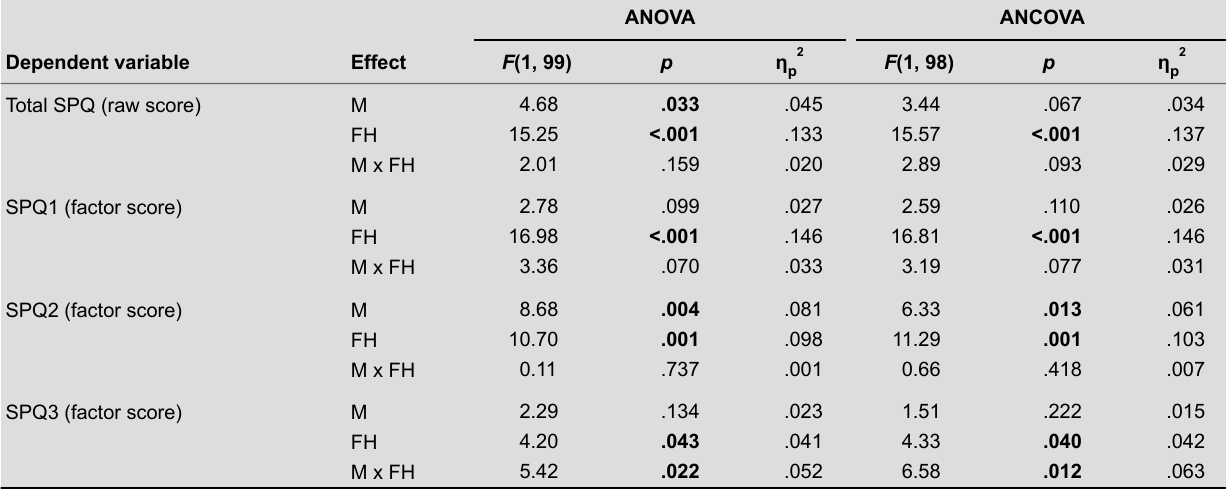
Results of Statistical Analyses of Migration Status and Family History on Schizotypal Personality Questionnaire Scores (N = 103)